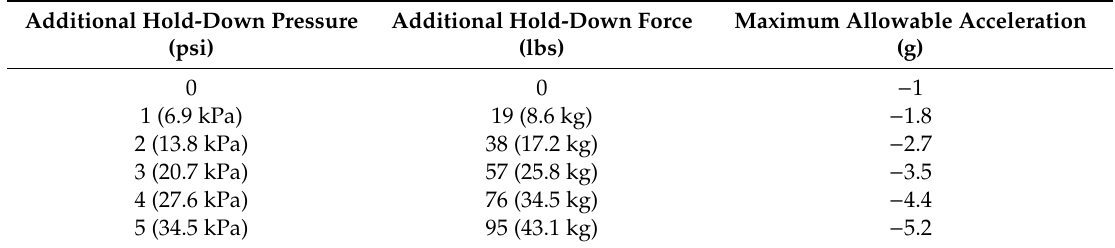
Table 3. Theoretical maximum acceleration with di ff erent levels of hold-down. Pressure in air